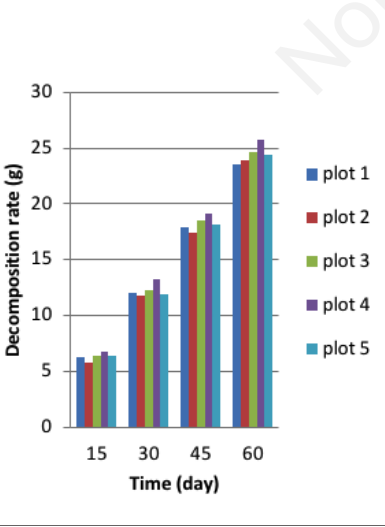
Figure 2. Decomposition rate of teak leaf